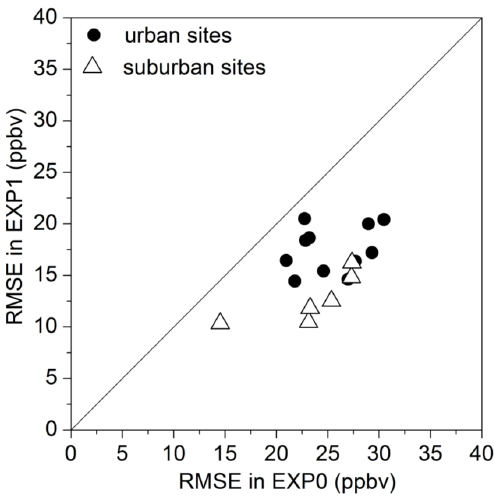
Fig. 3. Comparison of RMSE of 1-hour ozone forecast at urban sites (dots) and suburban sites 2 (triangles) in free run against those in EXP1. 3 Fig. 3. Comparison of RMSE of 1-h ozone forecast at urban sites 4 (dots) and suburban sites (triangles) in free run against those in EXP1. ing ozone initial values for short-term ozone forecast over Beijing and its surrounding areas. The fact that the impact of correcting ozone initial conditions at suburban sites is greater than that obtained from urban sites, might be due to the dif- ferent ozone formation mechanisms and their related differ- ent roles of uncertainty sources in ozone forecast in urban and suburban